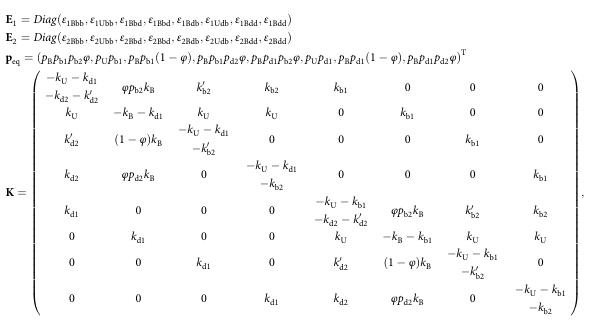
Table 4. In the analysis of three-color/DA1 segments of two-state binding with acceptor blinking (see Supplementary Fig.